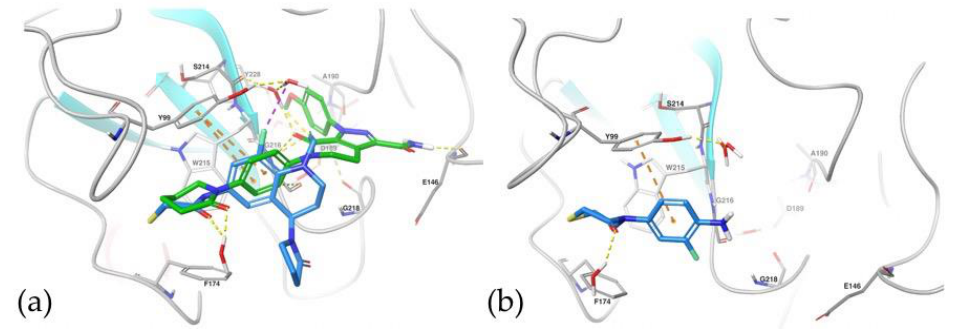
Figure 9. ( a ) Overlay of Apixaban (green) and compound 19 over active site of FXa. ( b ) Aniline derivative 8 on FXa.